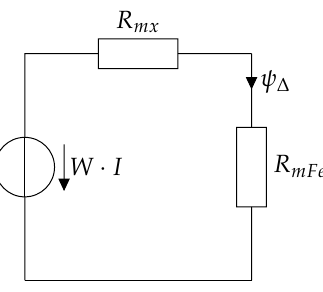
Figure 10. Magnetic equivalent circuit consisting of position-dependent air gap reluctance and hysteretic iron core reluctance.